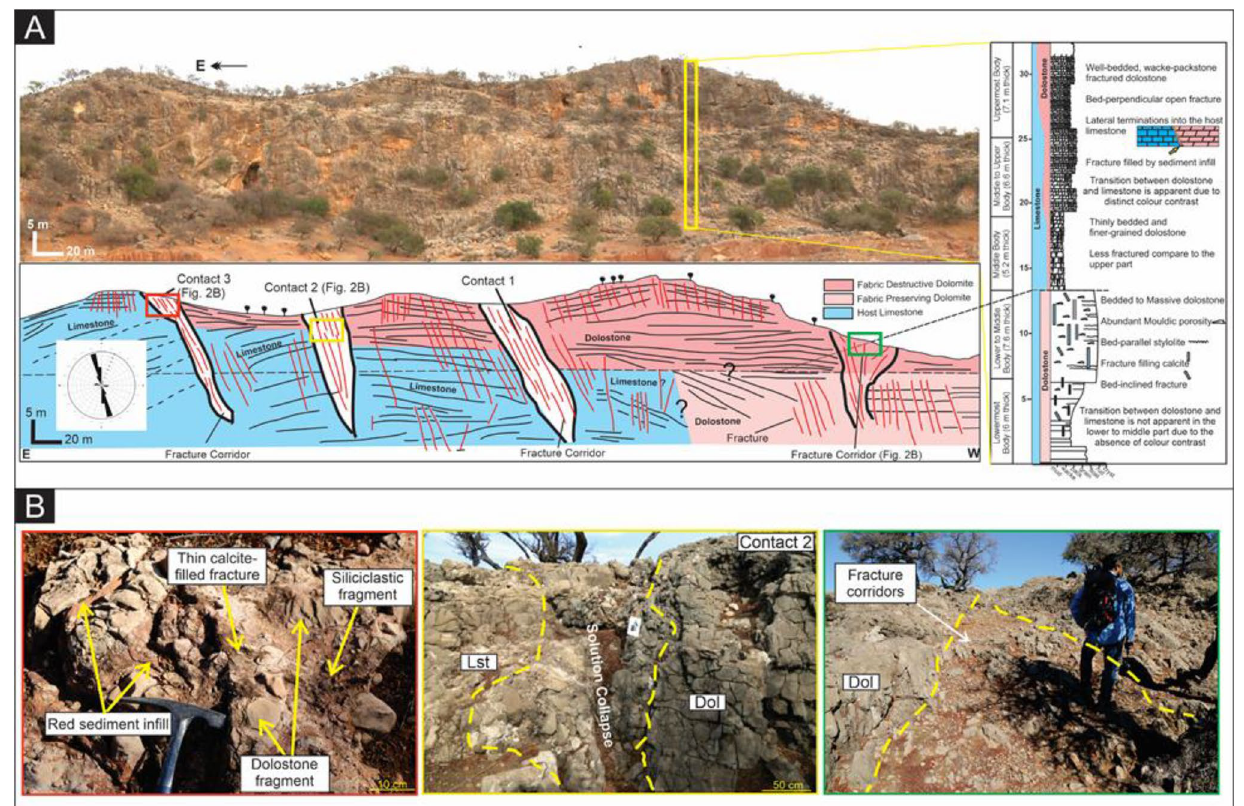
Figure 2. ( A ) Panoramic photos of the studied Early Jurassic outcrop in the Amsittene Anticline. Note the sketch displays several fracture corridors associated with dolomite-limestone contact. The right panel shows a measured sedimentary section of the Lower Jurassic carbonate. ( B ) Left panel: variation of filling material within fracture corridor, including calcite cement, rock fragments (carbonate and siliciclastic) and red sediment infill. Middle panel: dolomite (Dol)-limestone (Lst) bounded by wide deformation zone in contact 2. Right panel: highly fractured dolomite (Dol) and deformation bands within fracture